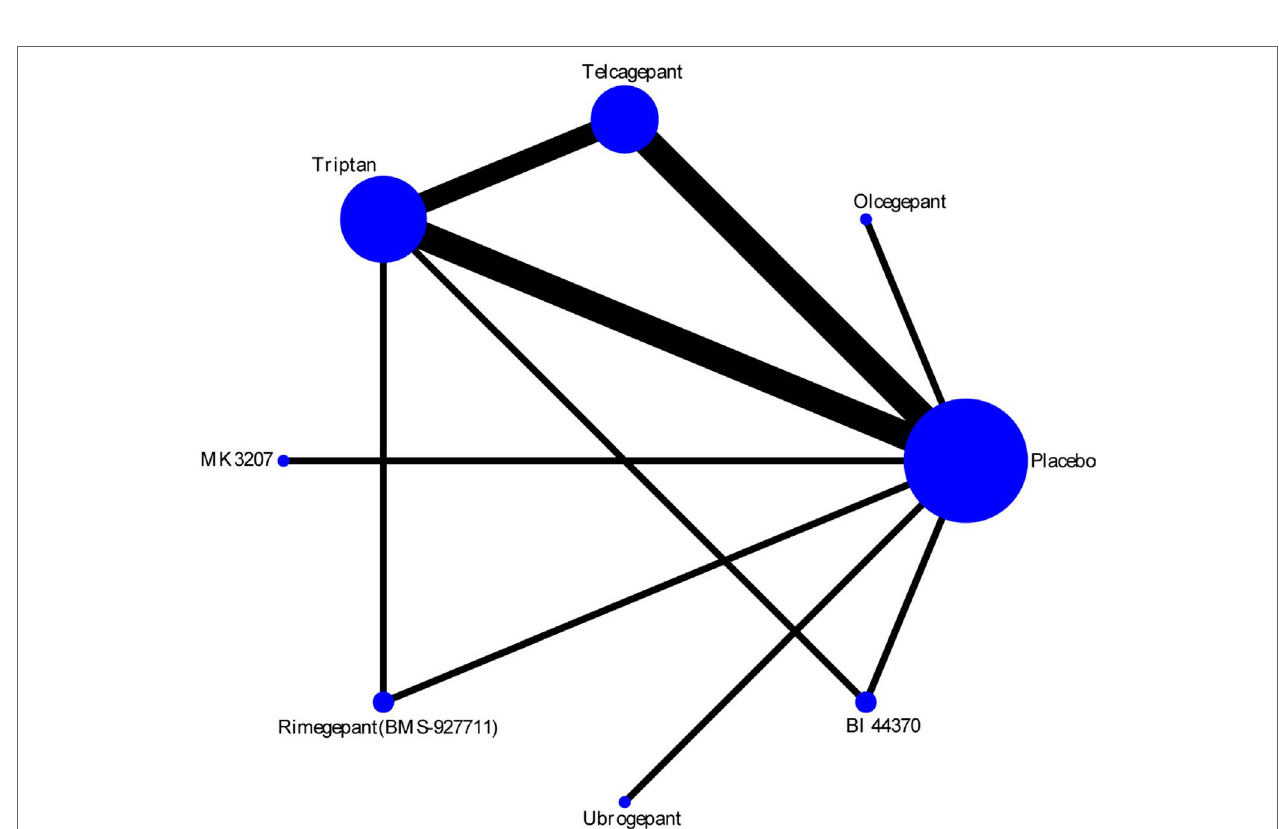
FIGURE 2 | Network plot for 2-h pain-free of six different calcitonin gene-related peptide (CGRP) antagonists. Lines represent direct comparisons within the randomized controlled trials (RCTs). The line thickness indicates the number of RCTs included in each